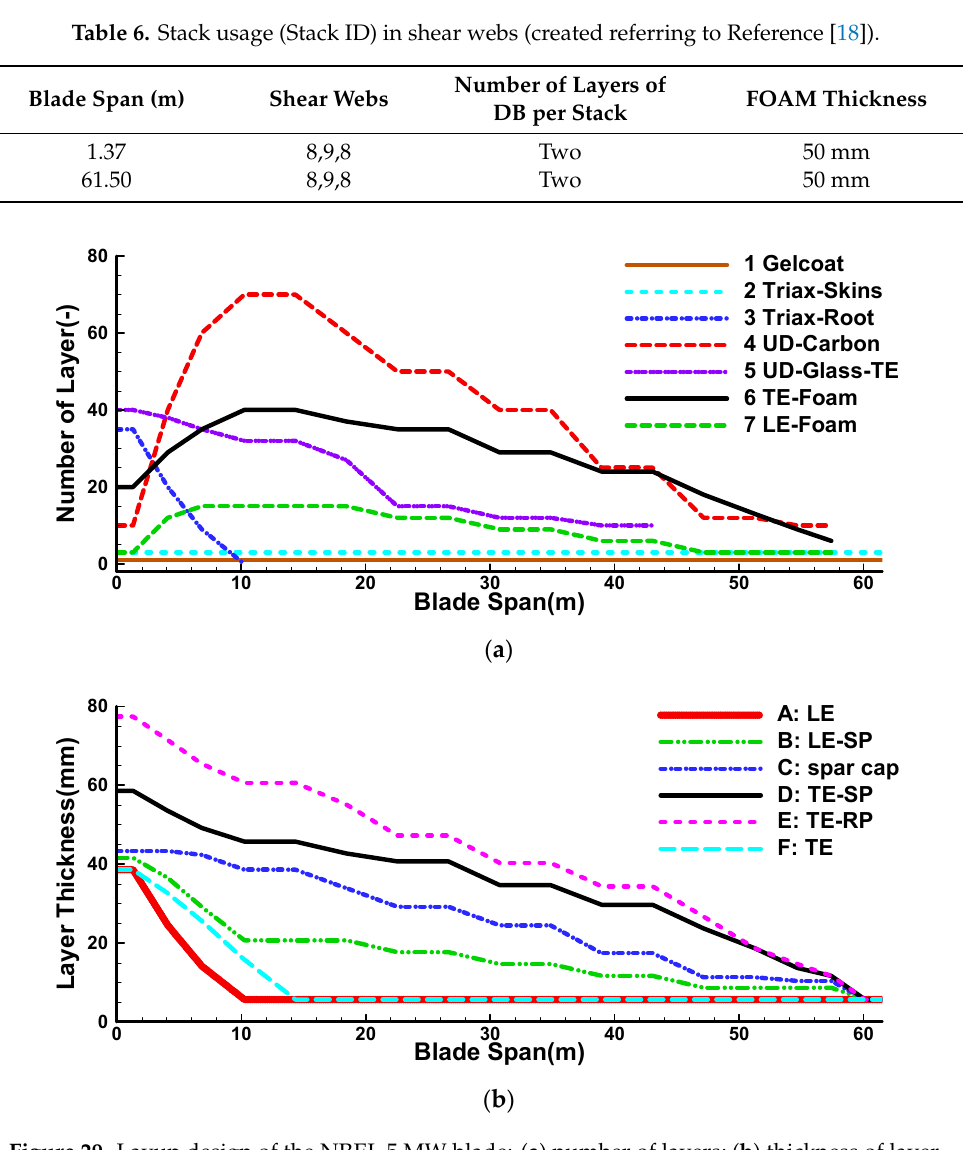
Figure 29. Layup design of the NREL 5 MW blade: ( a ) number of layers; ( b ) thickness of layer.